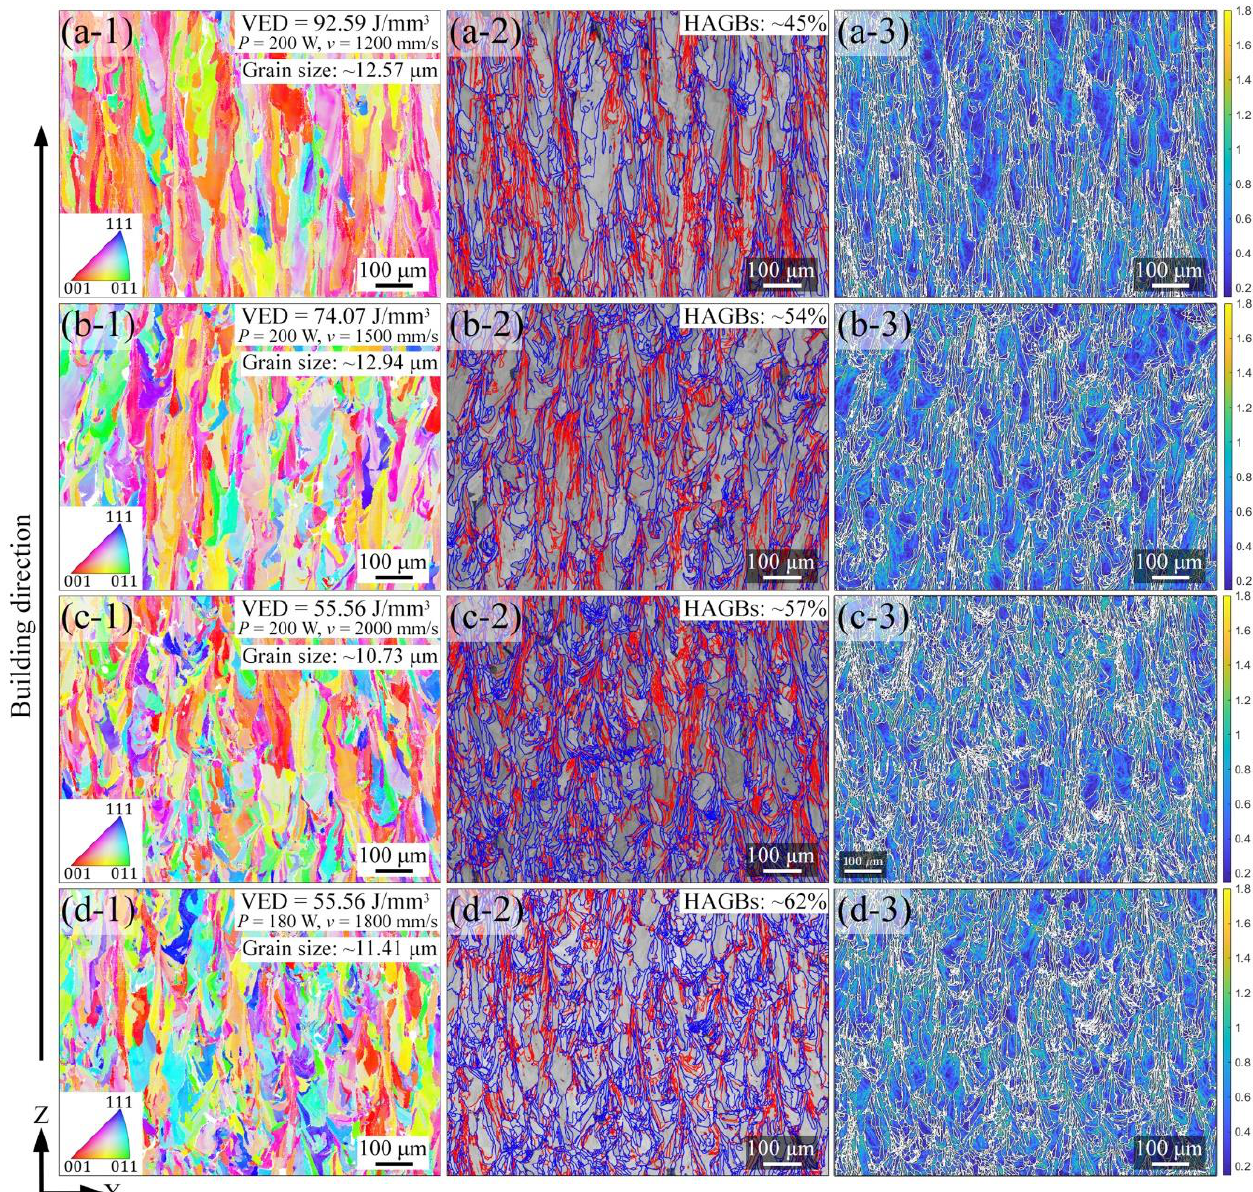
Figure 7. EBSD analysis on the xz-plane of AlCoCr 0.75 Cu 0.5 FeNi specimens produced by different process parameters. (a-1), (a-2), and (a-3) correspond to the EBSD IPF map, band contrast image with HAGBs (blue lines) and LAGBs (5 – 15°, red lines) map, and KAM image of the specimen produced with the VED of 92.59 J/mm 3 ( P = 200 W, v = 1200 mm/s), respectively. The rest is similar.